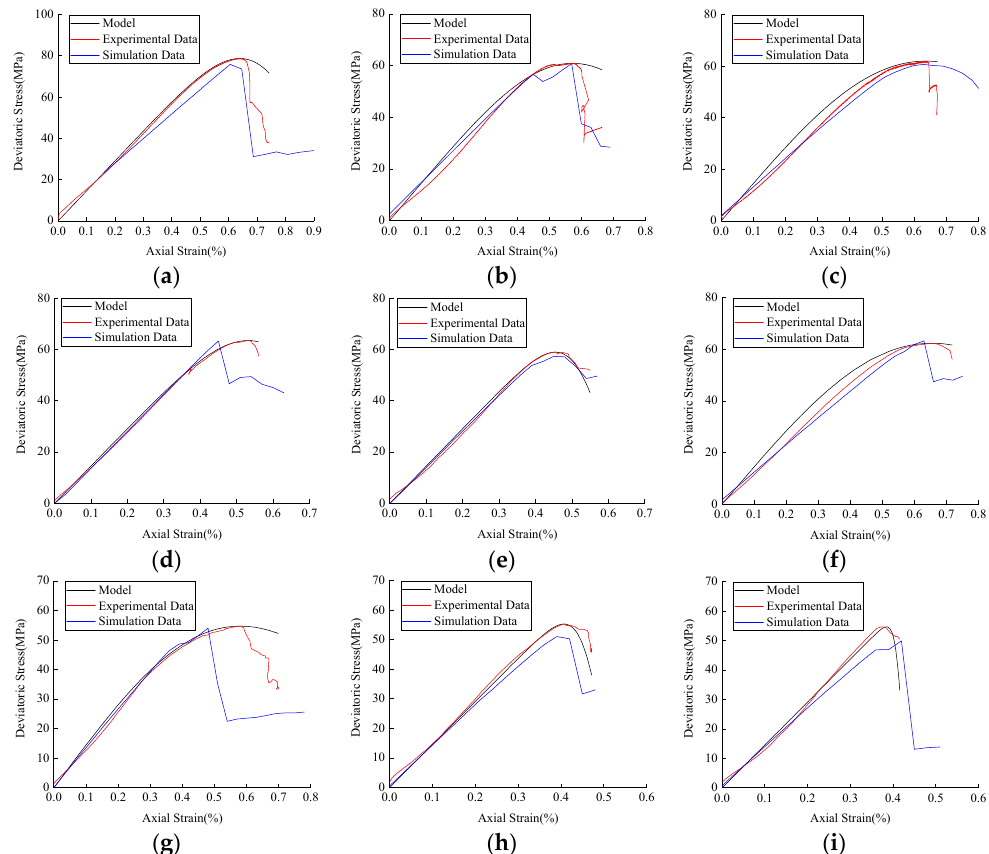
Figure 14. Comparison of the theoretical curves, simulation curves, and experimental curves of the multi-shape fractured samples: ( a ) SF0; ( b ) SF45; ( c ) SF90; ( d ) ST0; ( e ) ST45; ( f ) ST90; ( g ) SY0; ( h ) SY45; and ( i ) SY90. Table 5. Physical and mechanical properties of the samples with prefabricated fractures. Table 6. Typical constitutive model comparison Sample No. Peak Stress/MPa Peak Strain/%